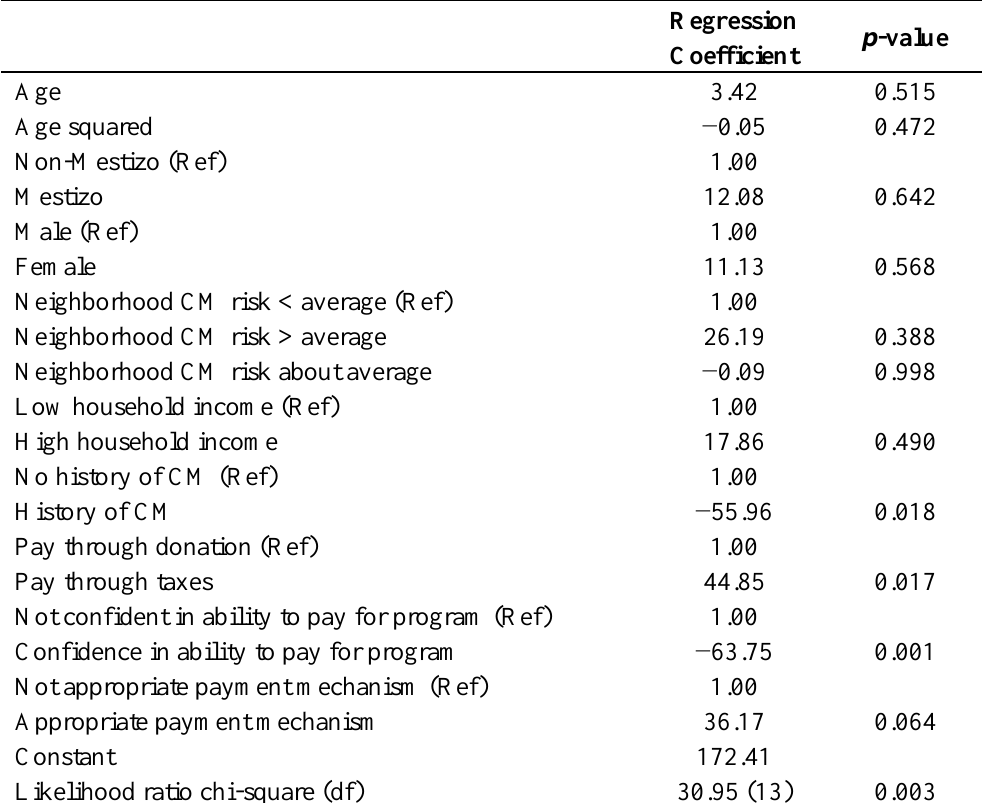
Table 2. Interval Regression Results of WTP for Reducing the Risk of CM Mortality by 1 in 100,000: Ecuador (N =